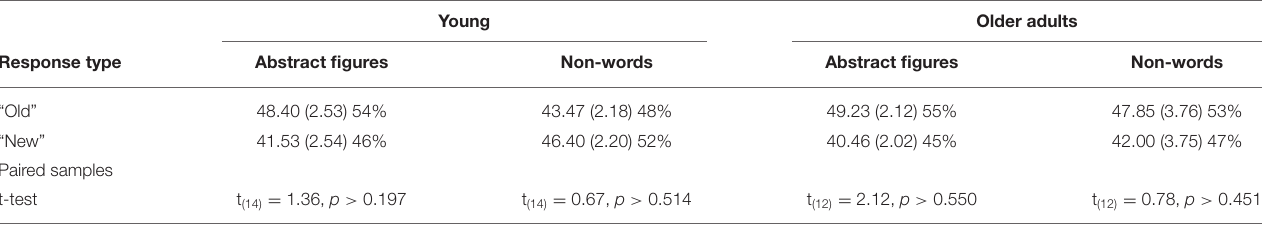
TABLE 2 | The overall number of old and new responses during the recognition phase Data represent the means (SEM) of the total “old” and “new” responses and the corresponding % compared to the 90 items/stimulus category (abstract figures and non-words), and the t-statistics for the young and the older adults.